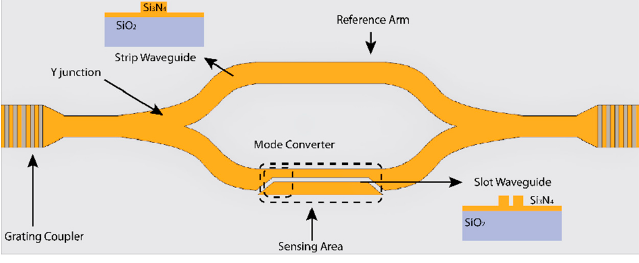
Figure 3. MZI with a slot waveguide as sensing arm, which is redrawn based on [30].